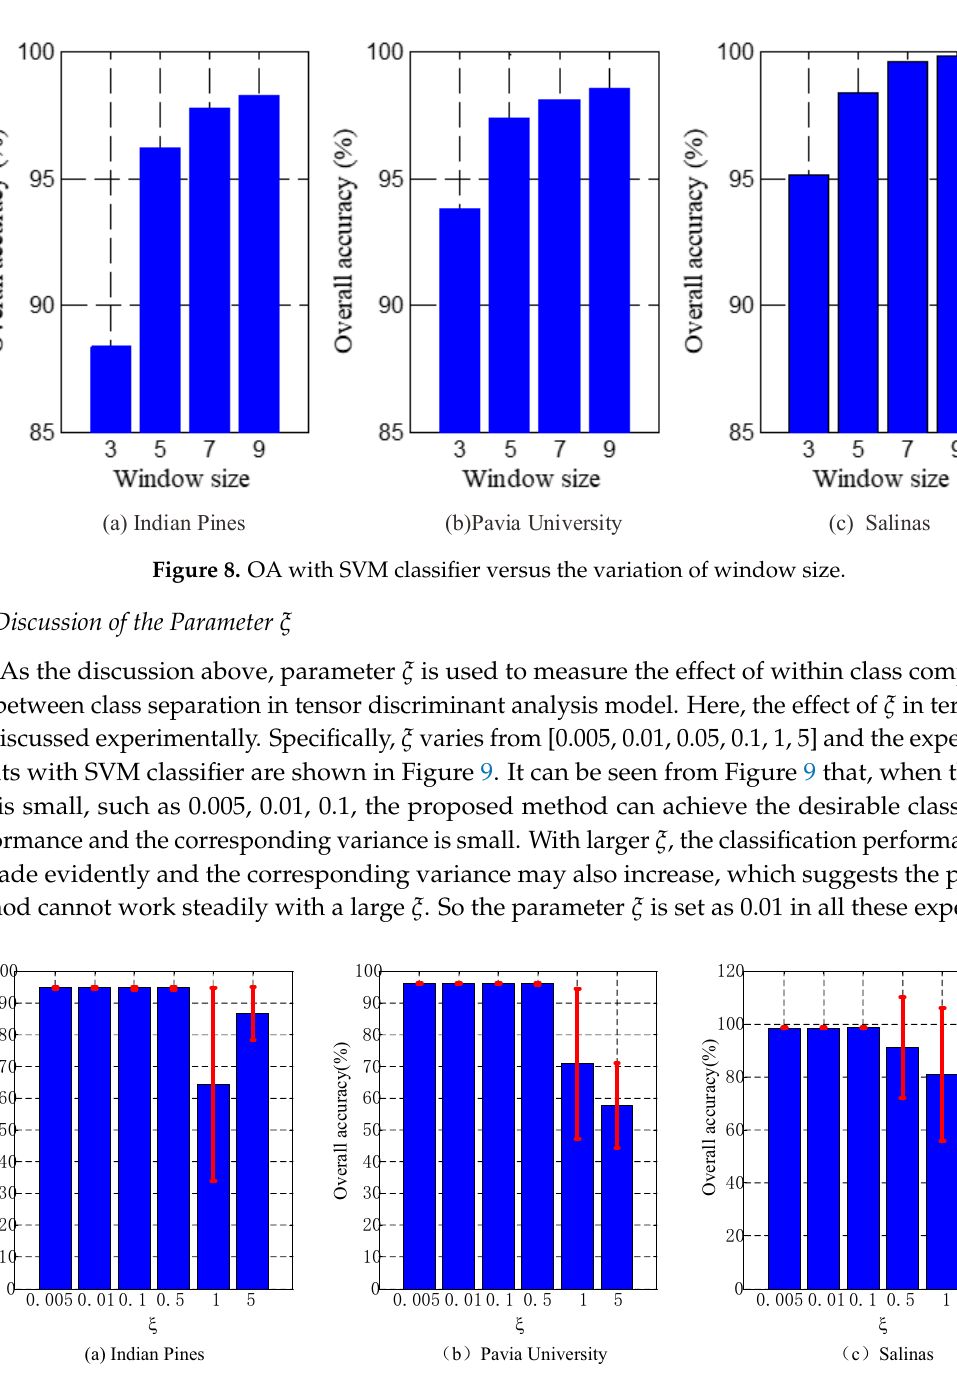
Figure 9. The effect of parameter ξ